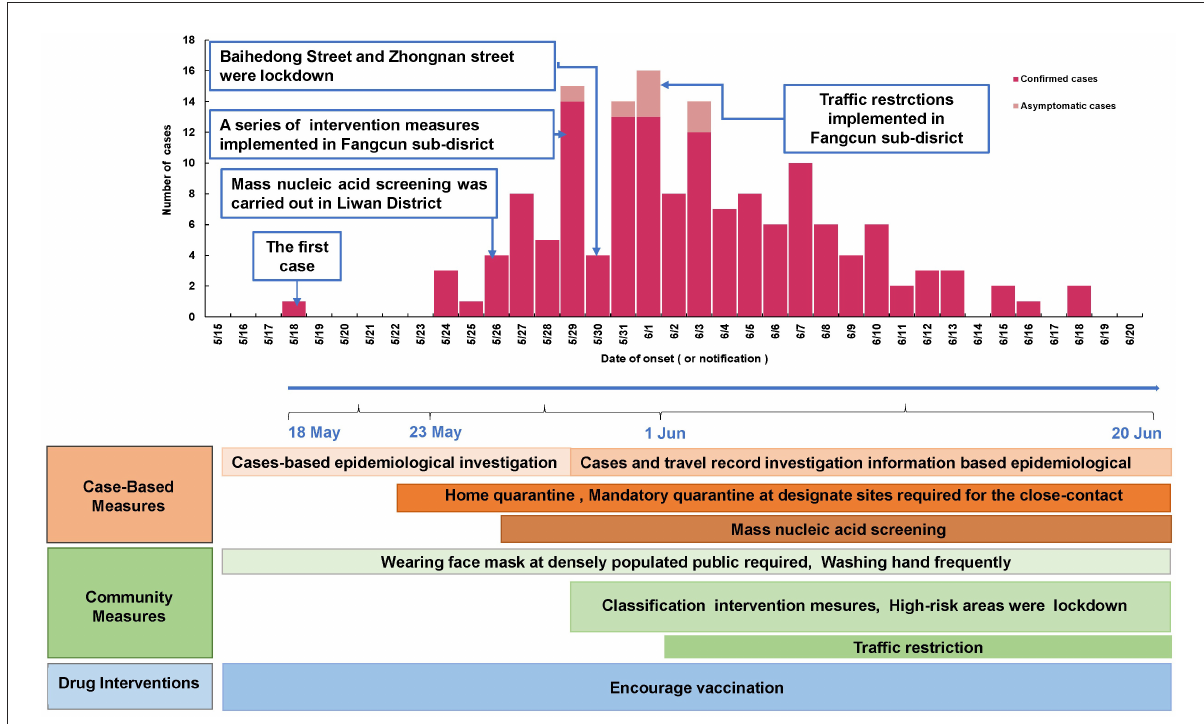
FIGURE1 Epidemic curve of and the intervention measures against SARS-CoV-2 Delta VOC outbreak in Guangzhou, from May 18, 2021 to June 18, 2021.